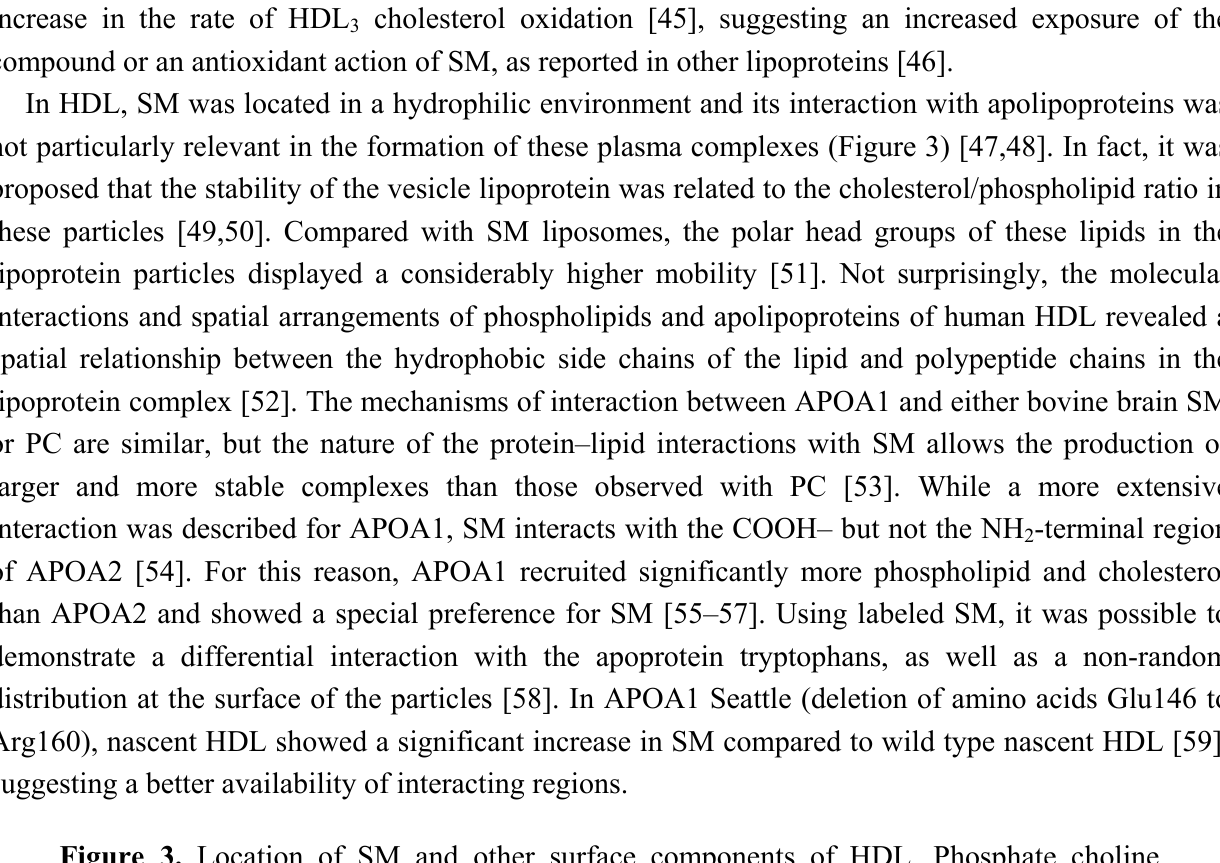
Figure 3. Location of SM and other surface components of HDL. Phosphate choline groups of sphingomyelin on the surface are depicted close to cholesterol molecules in a HDL